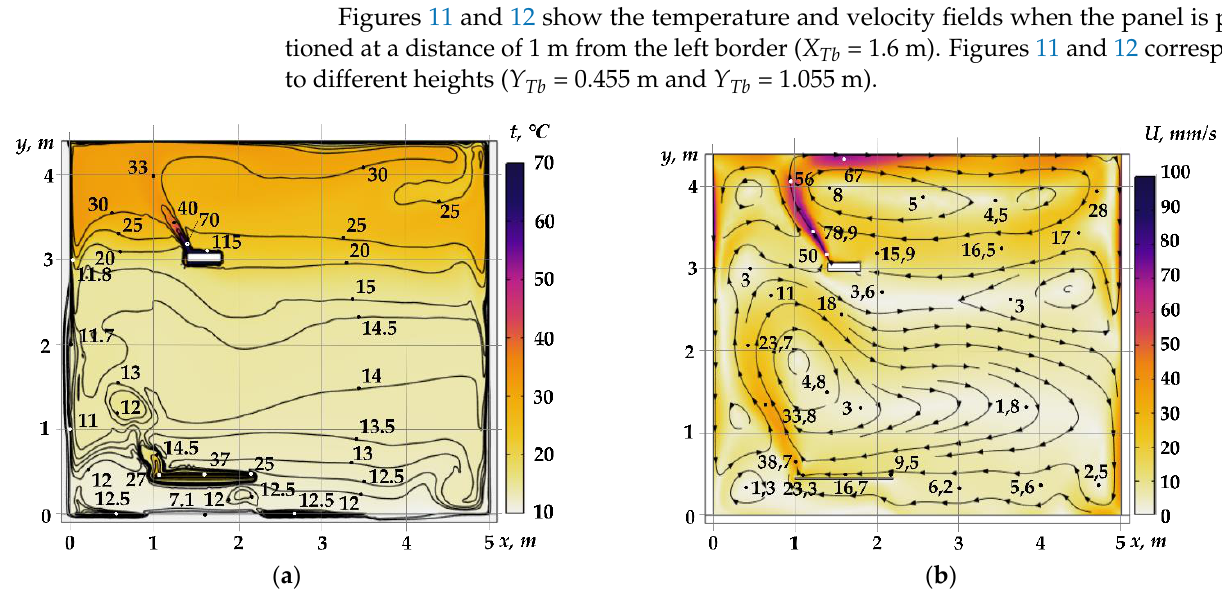
Figure 11. Temperature fields ( a ) and streamlines ( b ) for the area with the panel ( X Tb = 1.6 m, Y Tb = 0.455 m) in the GIH operation zone (τ = 60 min).